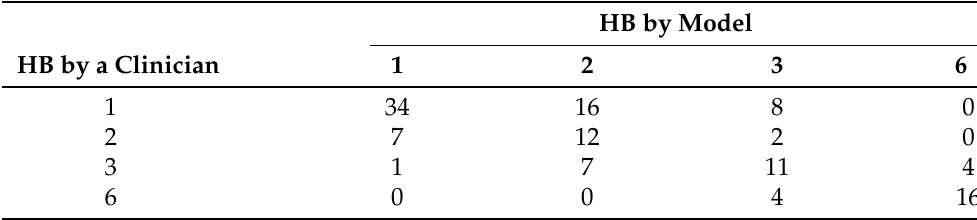
Table 10. Confusion matrix with numbers of (mis)classified cases by Ordinal Logistic Regression (OLR) model.